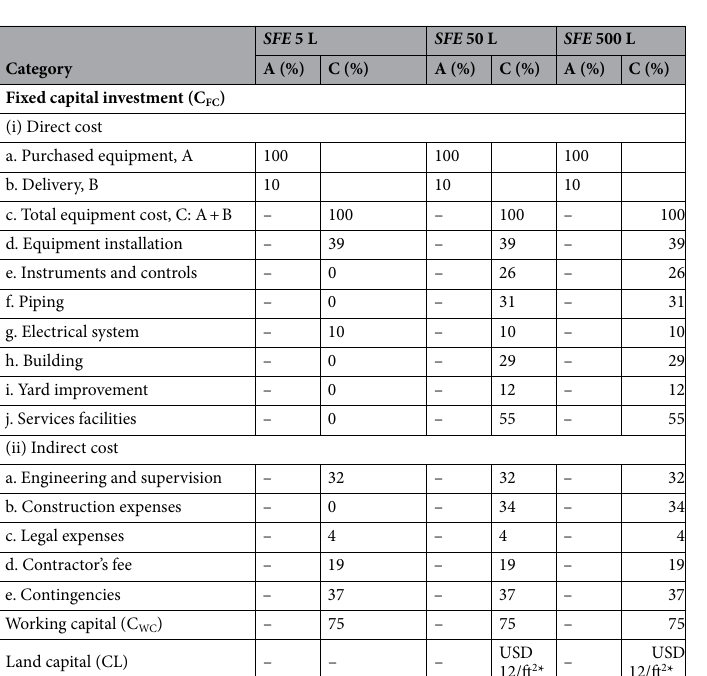
Table 6. Economic component for total capital investment calculation for different scale of SFE units. *Estimated land price in Malaysia based on several website searches.